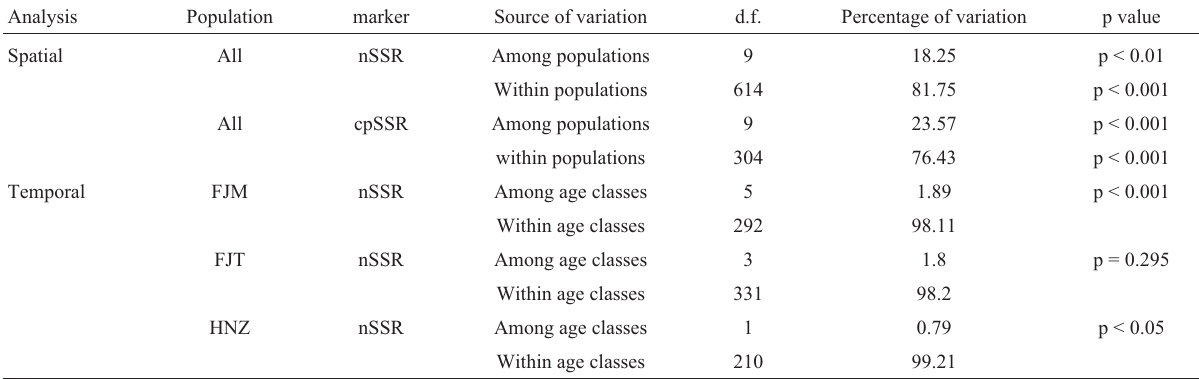
Table 3 - Results from analysis of molecular variance (AMOVA) from nSSR and cpSSR markers for Nothotsuga longibracteata